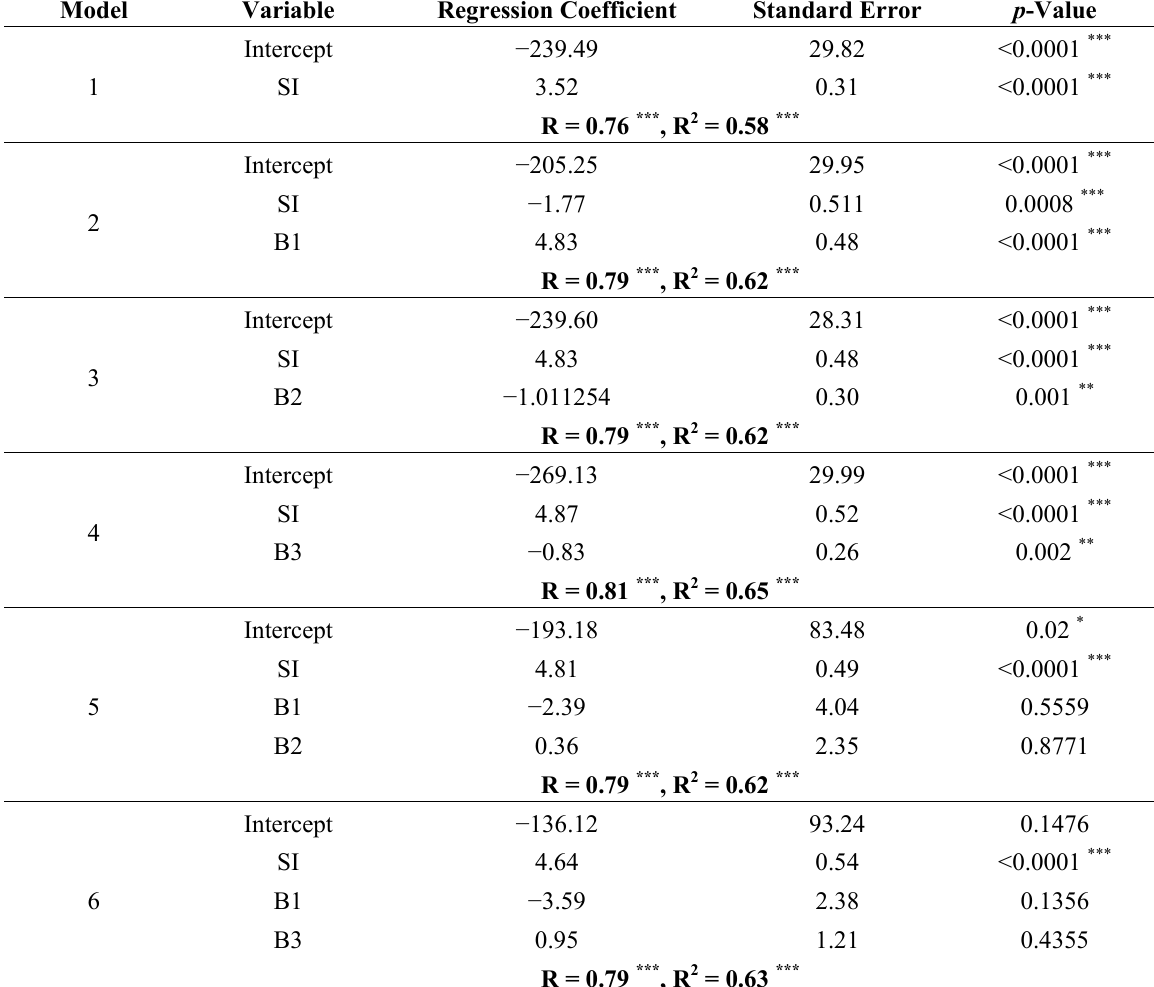
Table 4. Developed regression models to predict EC based on remotely sensed data. SI, Salinity Index.